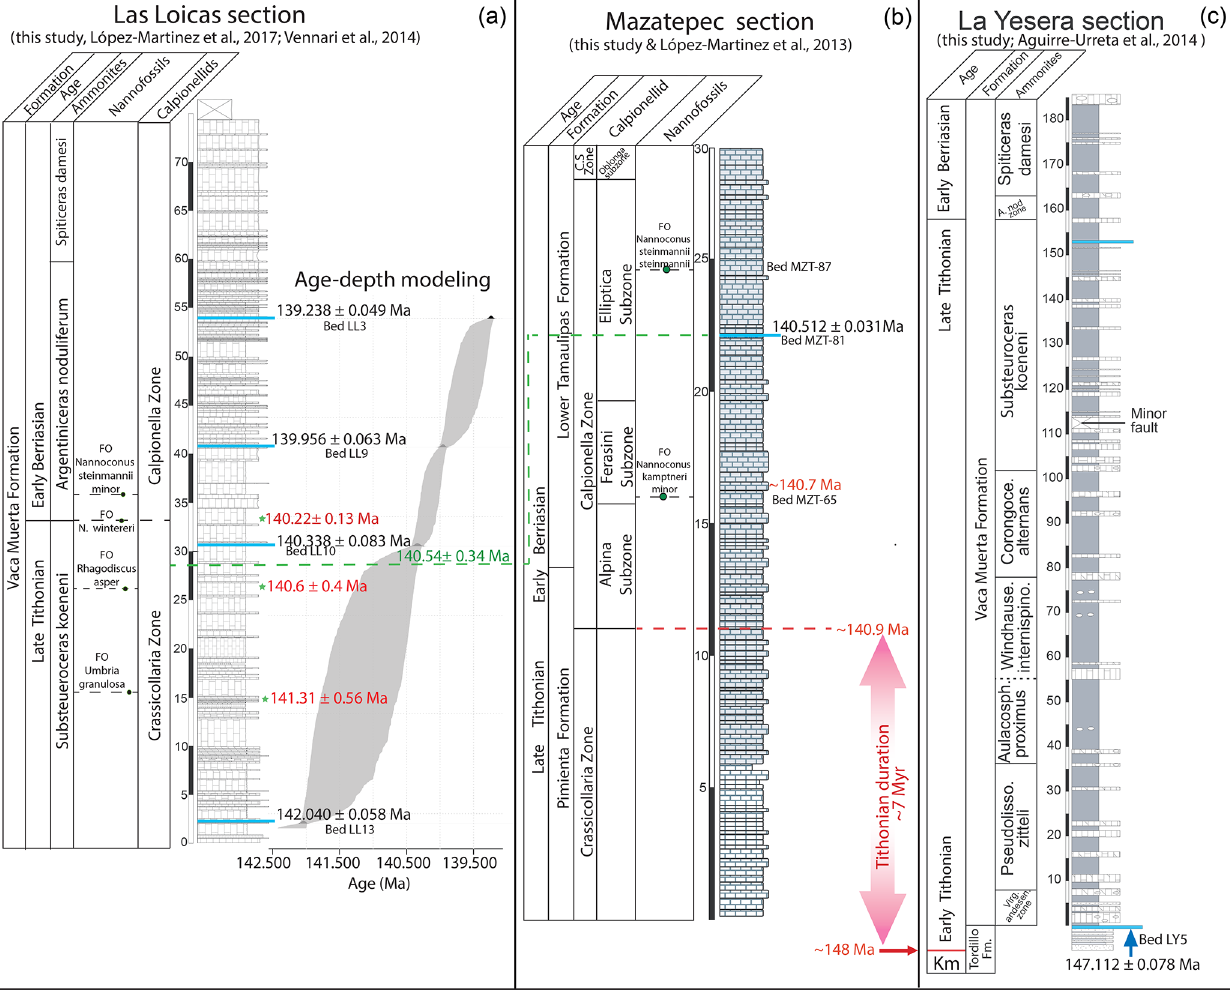
Figure 2. Age correlation between the Las Loicas, Mazatepec, and La Yesera sections. (a) Las Loicas section: ash beds in light blue with respective name and U–Pb dates in black font; age–depth modeling ages are in red font next to green stars (this study); ammonite and nannofossil zonation after Vennari et al. (2014); calpionellid zonation after Lopez-Martinez et al. (2017). (b) Mazatepec section: ash bed in light blue with respective name and U–Pb age in black font, age calculated from sedimentation rate in red font (this study); calcareous nannofossils (this study); calpionellid zonation after Lopez-Martinez et al. (2013b). (c) La Yesera section: ash bed in light blue with U–Pb age (Aguirre-Urreta et al.,